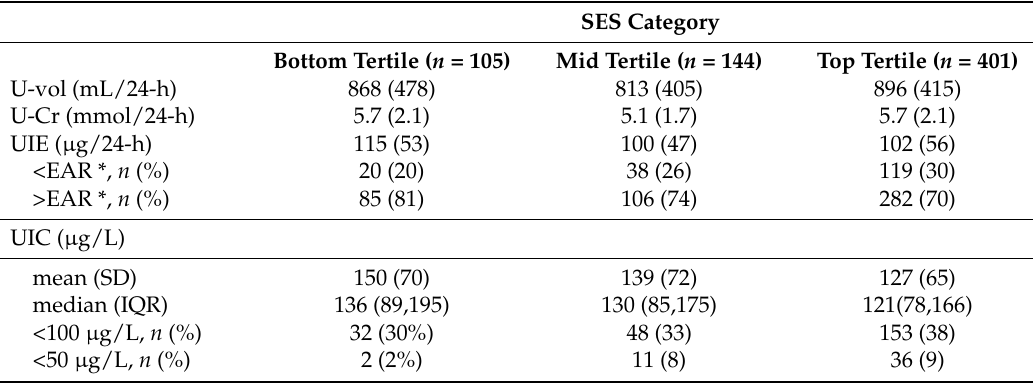
Table 3. Urinary parameters by school postcode socioeconomic status ( n =